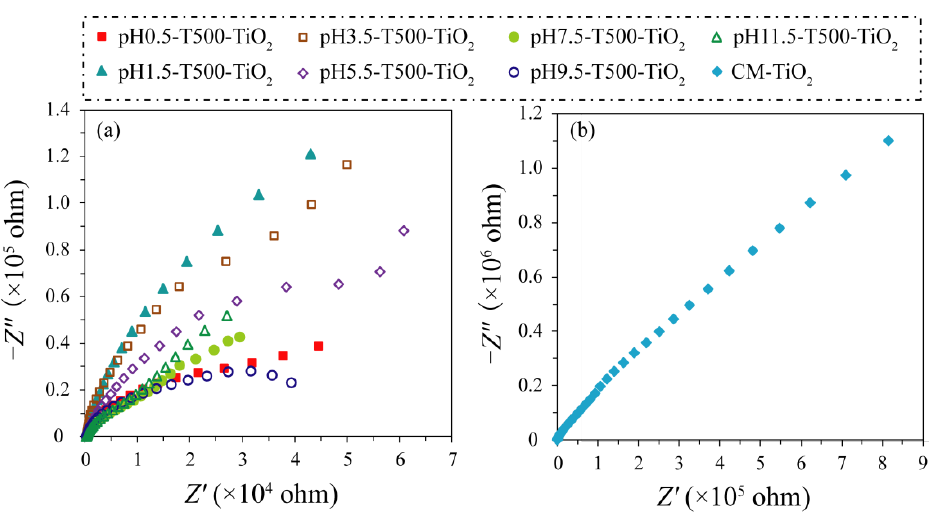
2 and CM-TiO 2 samples.